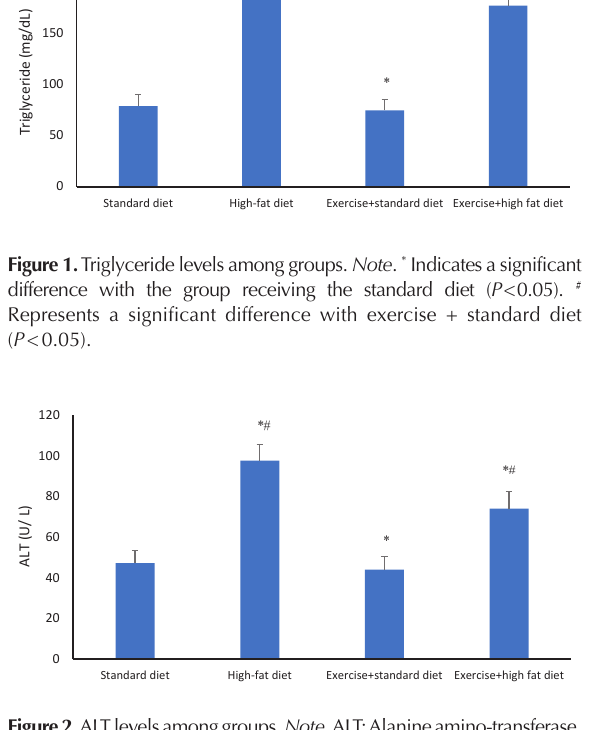
Figure 2. ALT levels among groups. Note . ALT: Alanine amino-transferase. * Demonstrates a significant difference with the group receiving the standard diet ( P < 0.05). # Indicates a significant difference with exercise + standard diet ( P < 0.05).